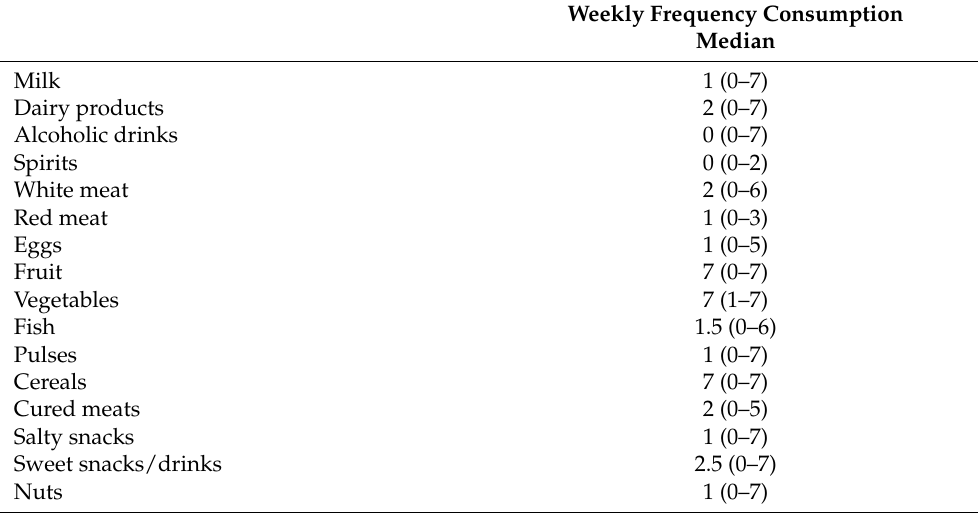
Table 3. Median of weekly frequency of patients’ food consumption. Range in the brackets.